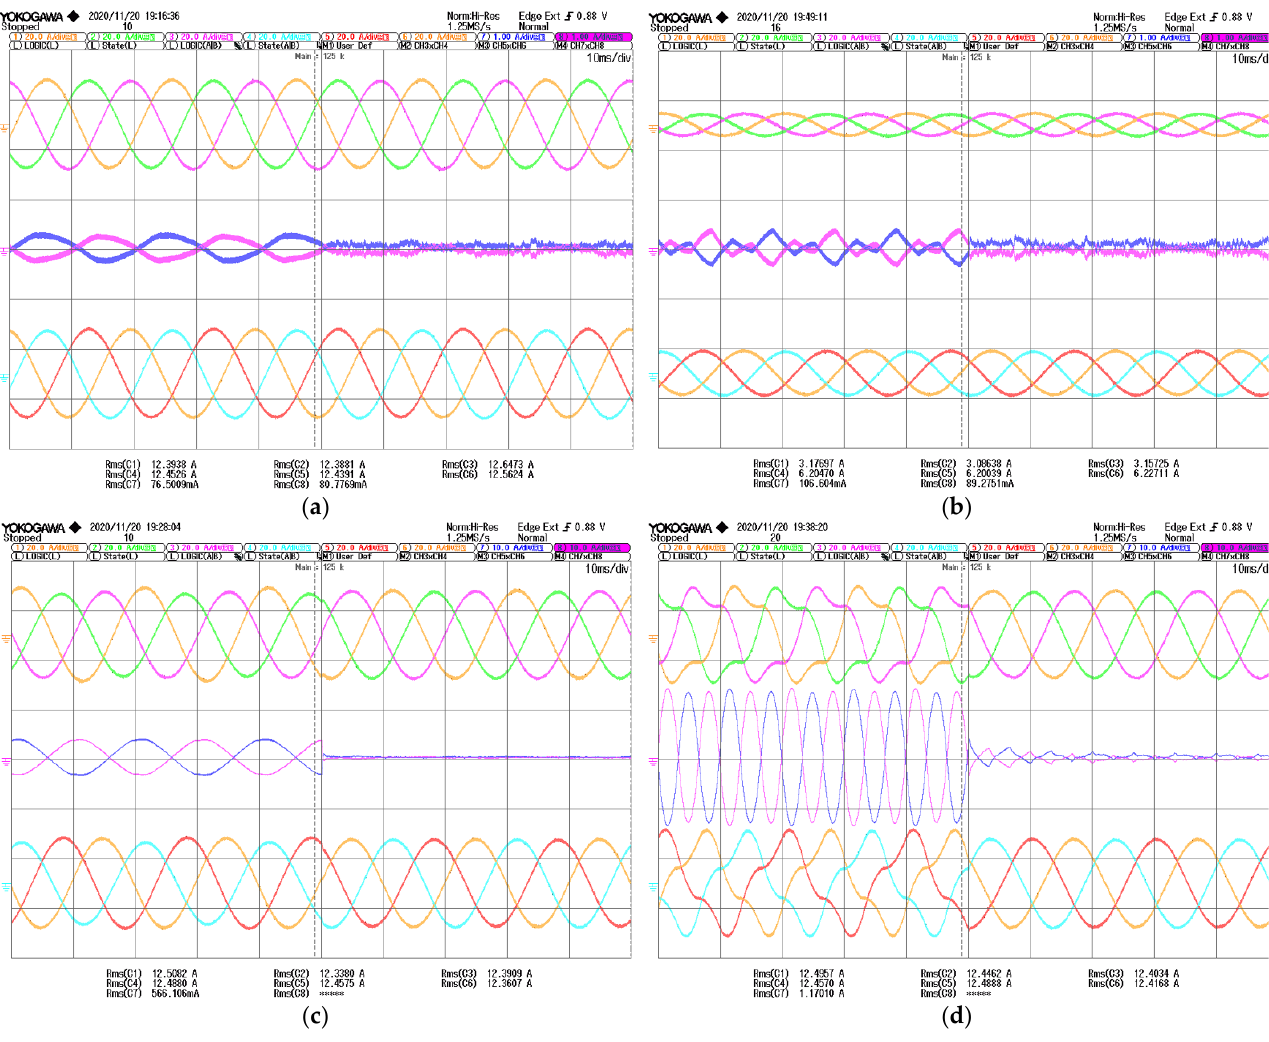
Figure 11. Experimental results of the control of the circulating currents ( a ) with unbalanced inductances in both inverters, ( b ) with unbalanced load factor between inverters, ( c ) with unbalanced inductances in the same inverter, ( d ) with a different modulation in each inverter. * stands for values that the oscilloscope did not calculate. In this case, the RMS value of Channel Table 6. Real values of the inductance L f of 5 mH.